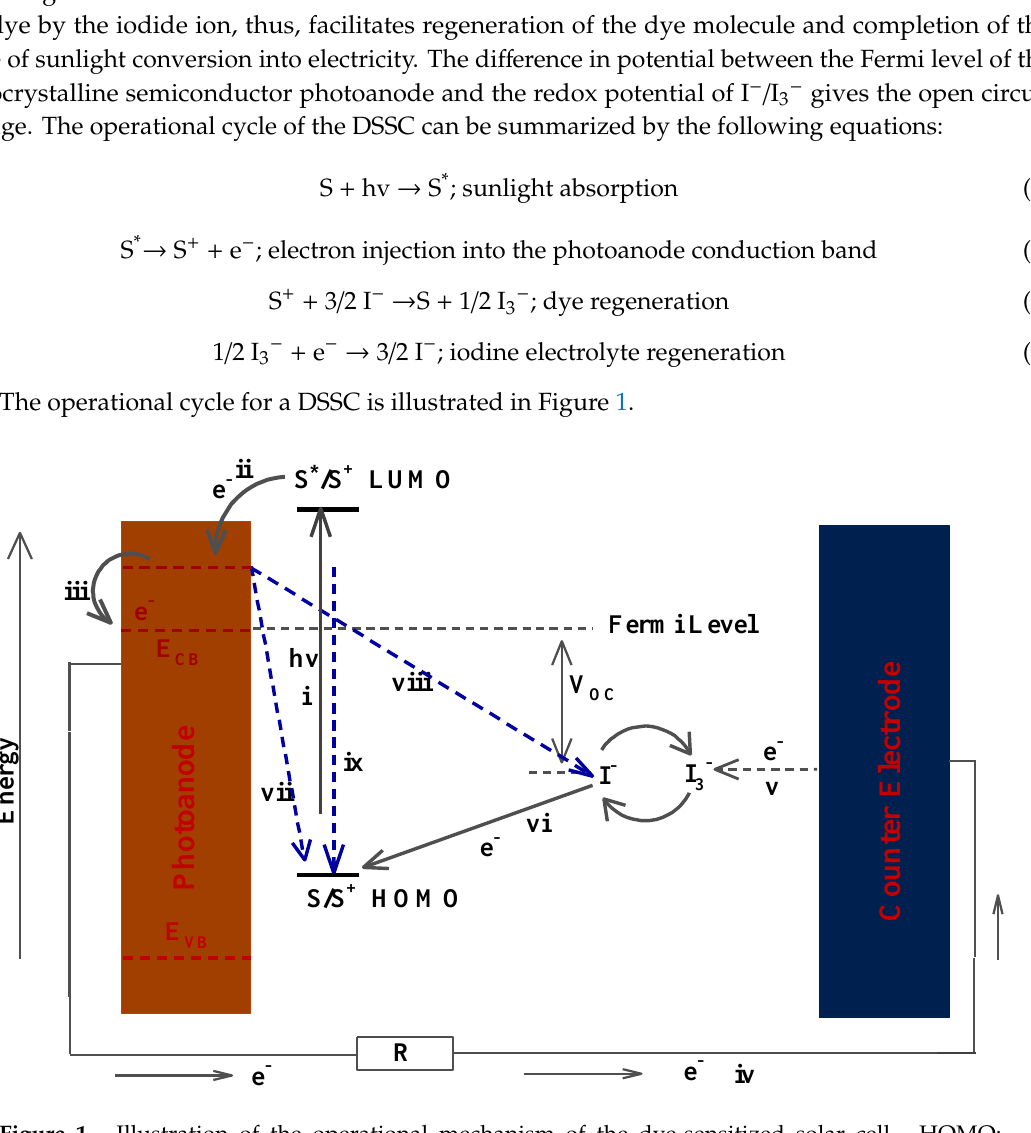
Figure 1. Illustration of the operational mechanism of the dye-sensitized solar cell. HOMO: highest occupied molecular orbital; LUMO: lowest unoccupied molecular orbital (hv—energy, E CB —conduction band energy, R—resistance, V OC —open circuit voltage. Reproduced with permission from Reference [19], MDPI 2018.